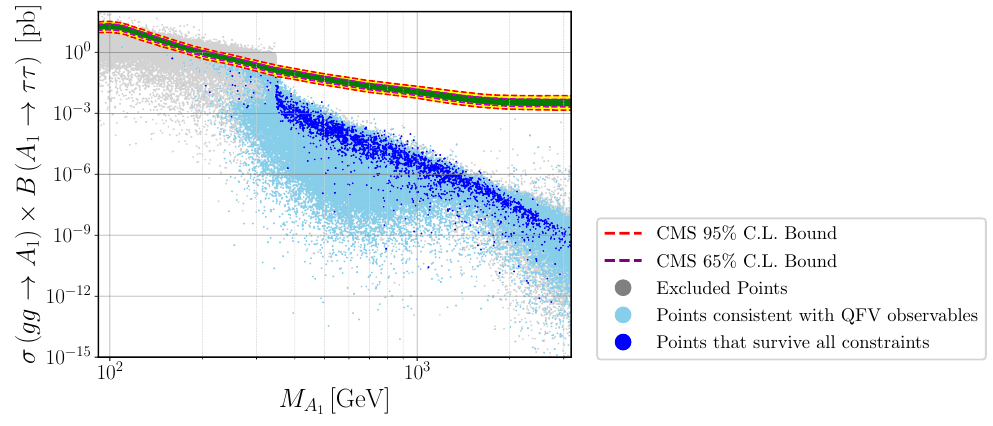
Figure 9 . The pseudoscalar A 1 production cross section in gluon-gluon fusion at the LHC center of mass energy of 13 TeV, times its decay branching ratio to τ ¯ τ as a function of m represent the sets of scenarios excluded by not obeying at least one QFV observable at 2 σ . Blue points, both dark and light shades, correspond to an agreement with all QFV observables at least at 2 σ level. Those points that are further allowed by all imposed constraints are represented by the dark blue points. The 1 and 2 σ observation limits available from the CMS Collaboration for searches in this channel are taken from